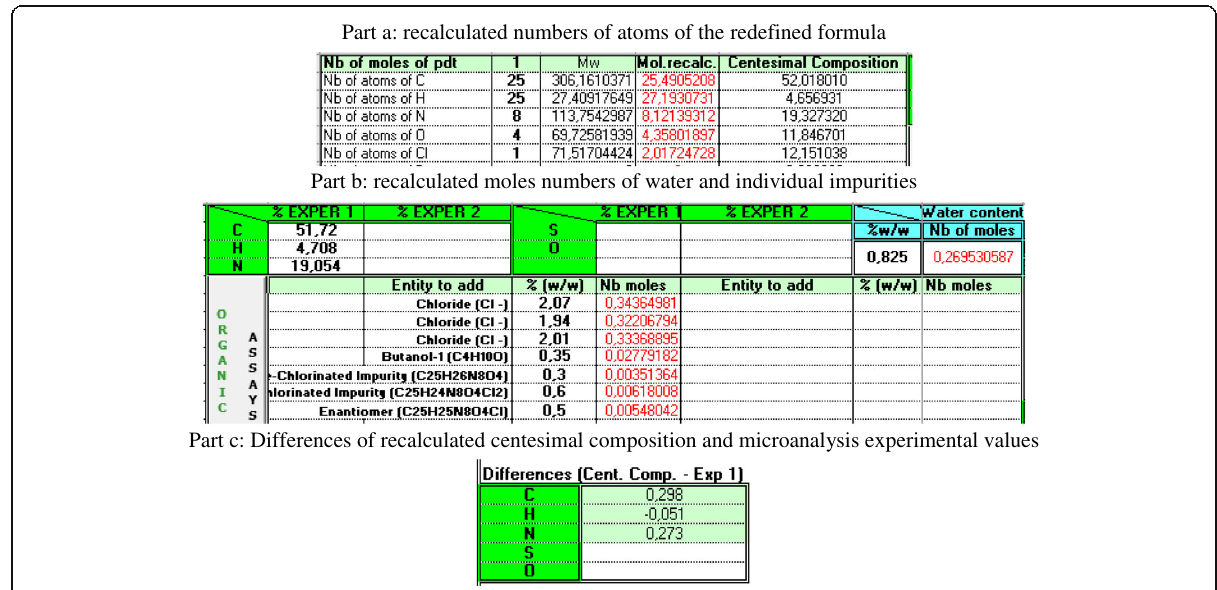
Fig. 8 User interface screenshots (parts a, b, c) –– example of enantiomeric impurity insertion in the impurity profile, for the compound C 25 H 25 N 8 O 4 Cl,